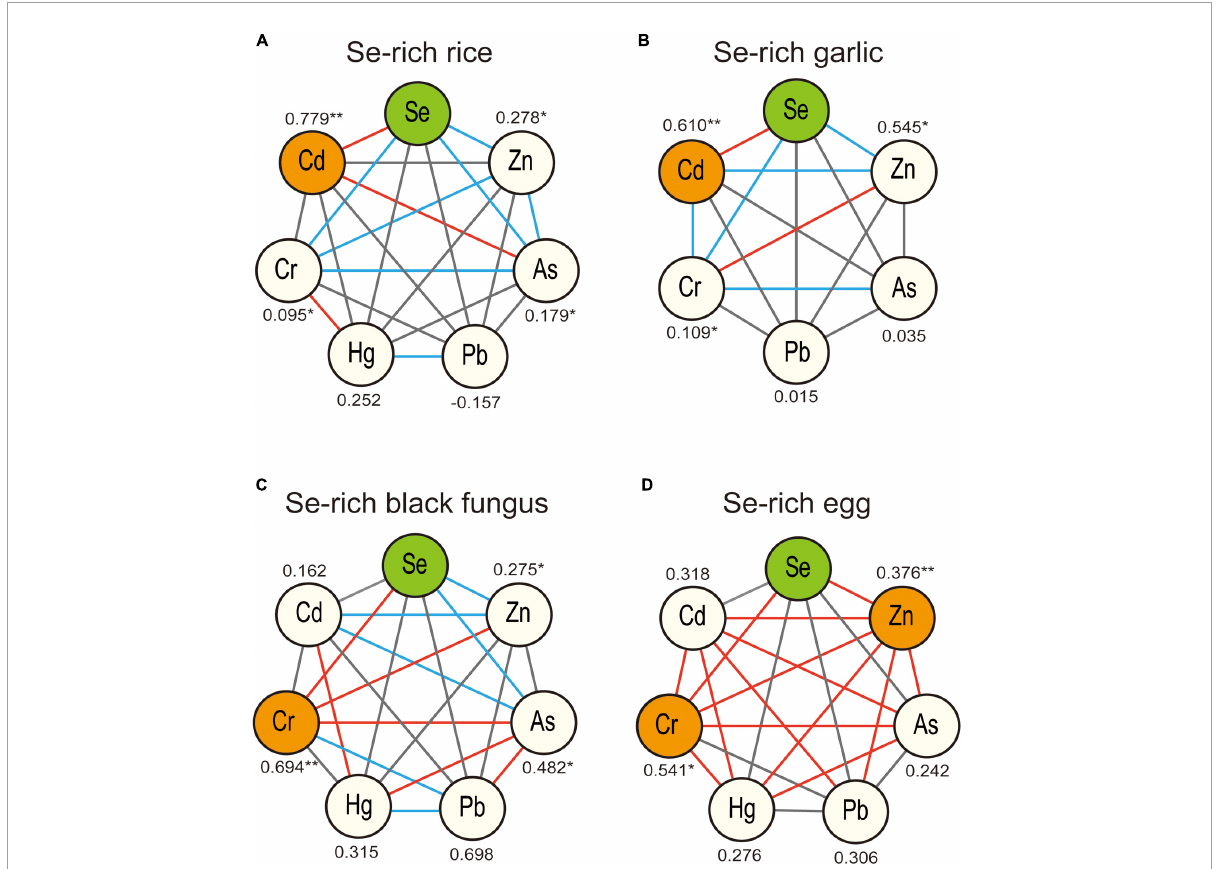
FIGURE2 Pearson correlations analysis of Se and potential coexisting elements in Se-rich rice (A) , garlic (B) , black fungus (C) , and egg (D) . **Represents for highly significant correlation, p < 0.01, *represents for significant correlation, p < 0.05. The connections between the nodes represent for the significance of the correlation between different elements, solid red line represents for highly significant correlation, p < 0.01, solid blue line represents for significant correlation, p <